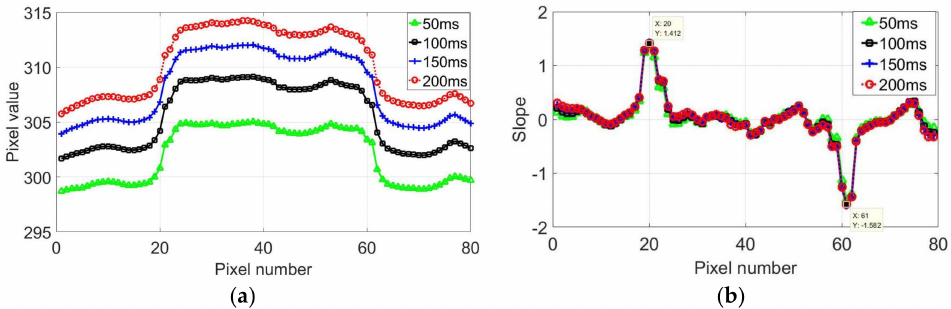
Figure 7. Data analysis of image: ( a ) temperature distribution of line at different times and ( b ) slope of first derivation at different